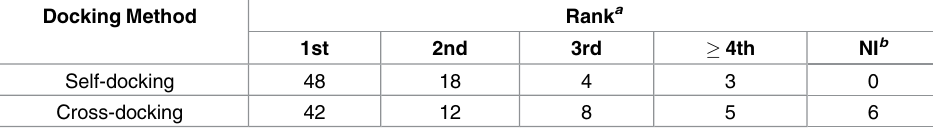
a Rank: relative position of the bioactive conformation within docked conformations sorted by predicted RBA b The number of ligands for which molecular docking could not generate the bioactive